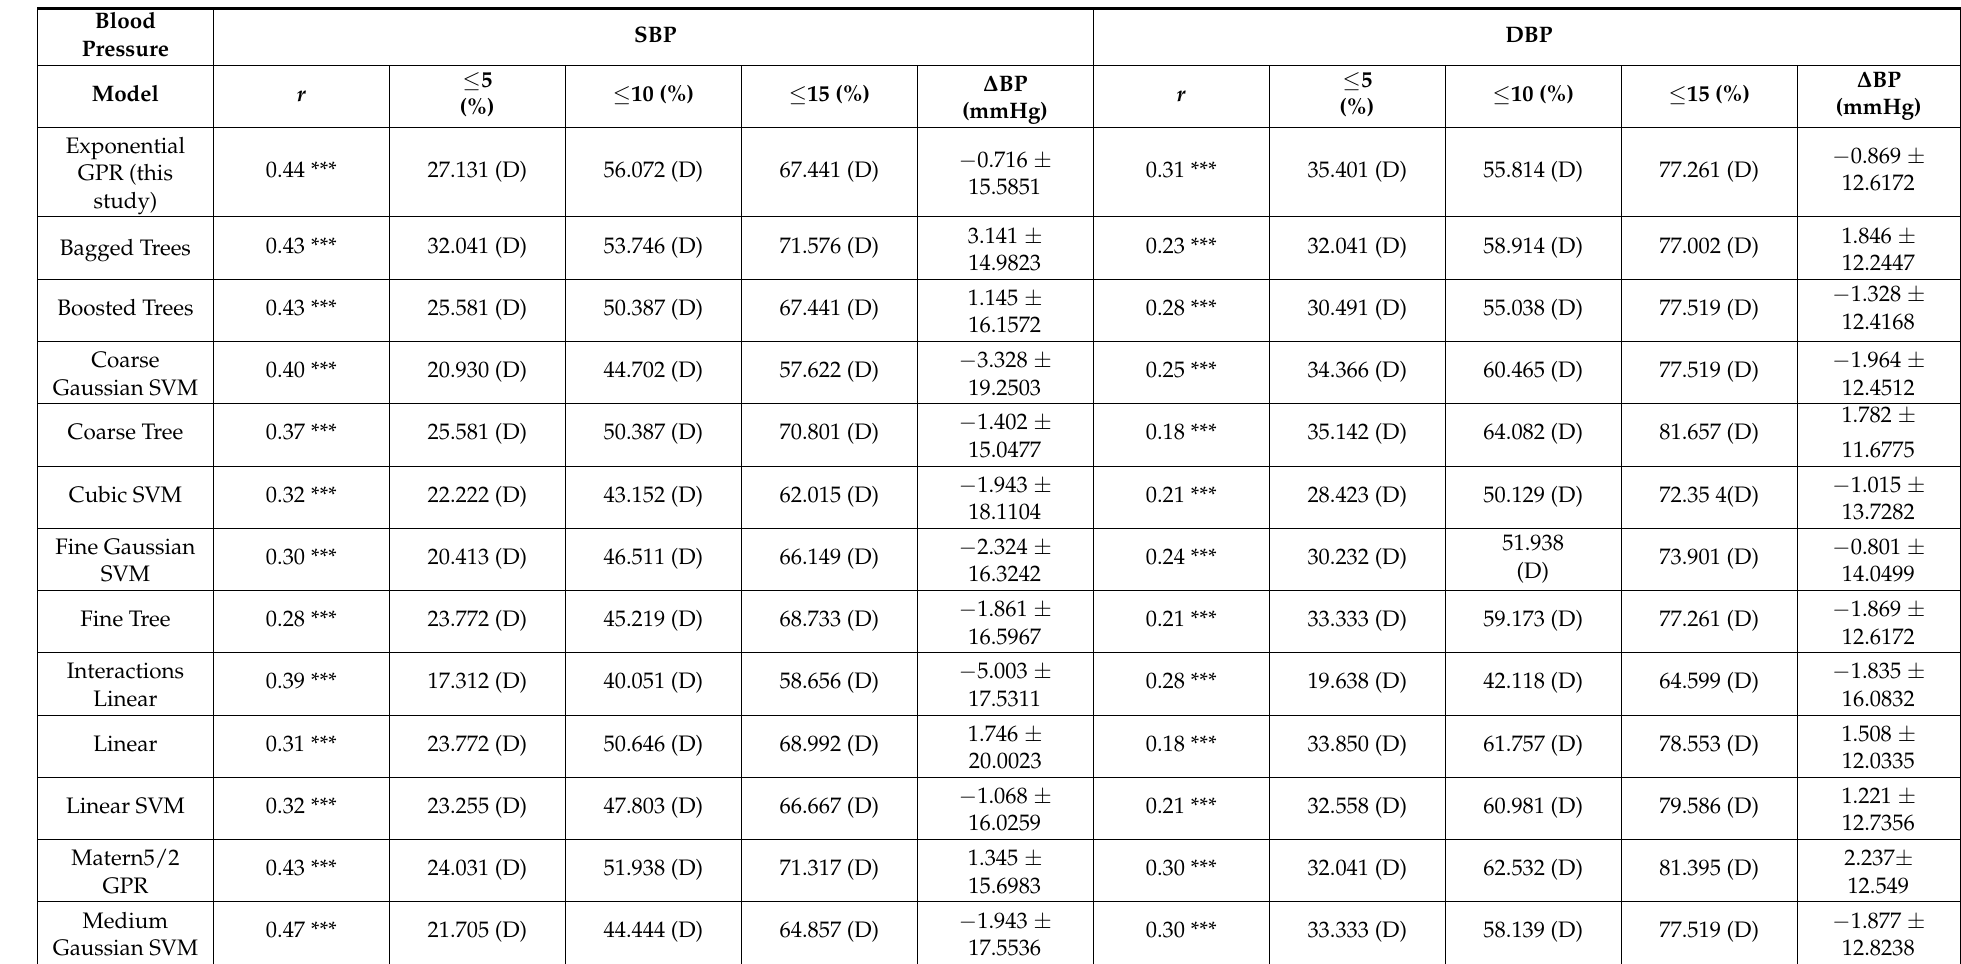
Table 3. Comparison of accuracy between all ML models for SBP and DBP without calibration and age